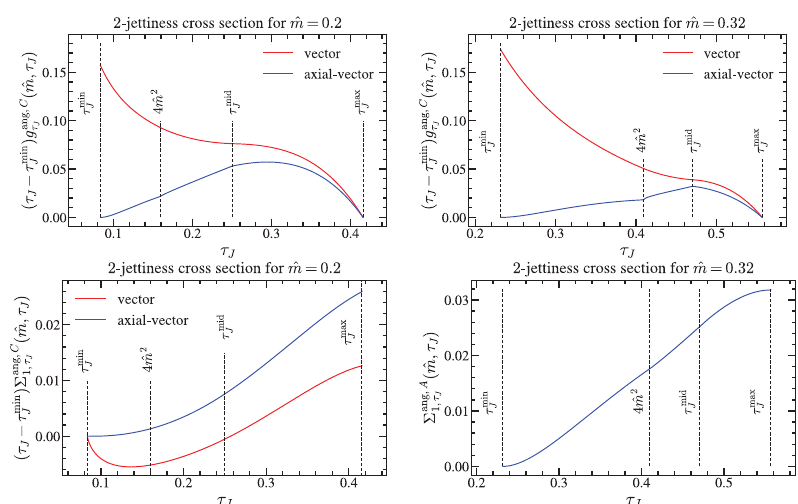
Figure 6: Di ff erential and cumulative cross sections for thrust and heavy jet mass for values of the reduced mass below and above m crit